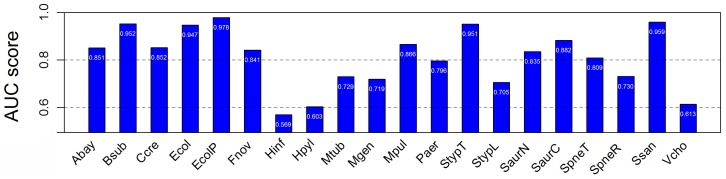
AUC scores from cross-organism Geptop prediction.The range of AUC is from 0.5 to 1.